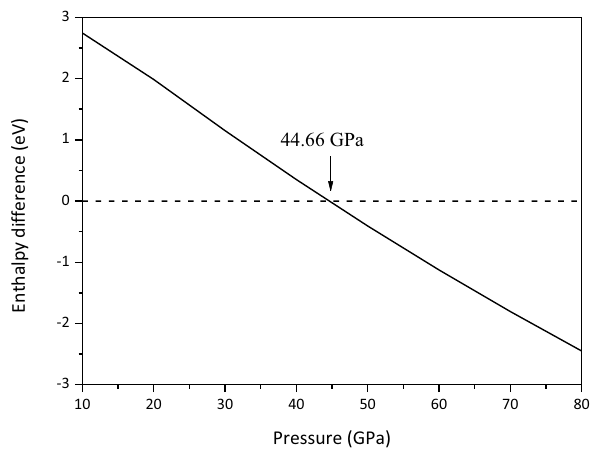
Figure 2. Enthalpy difference between Mg 2 CO 4 - P 2 1 / c and Mg 2 CO 4 - Pnma .